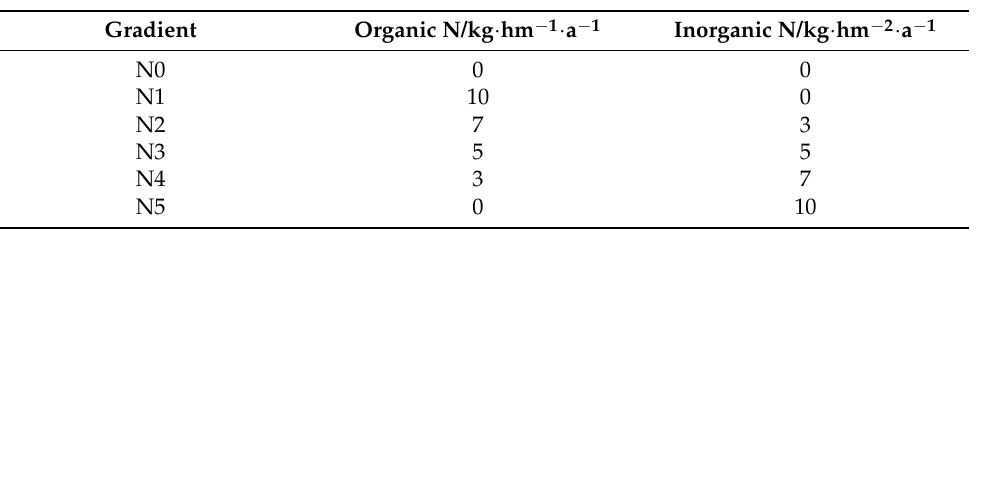
Table 1. Nitrogen application gradient in the